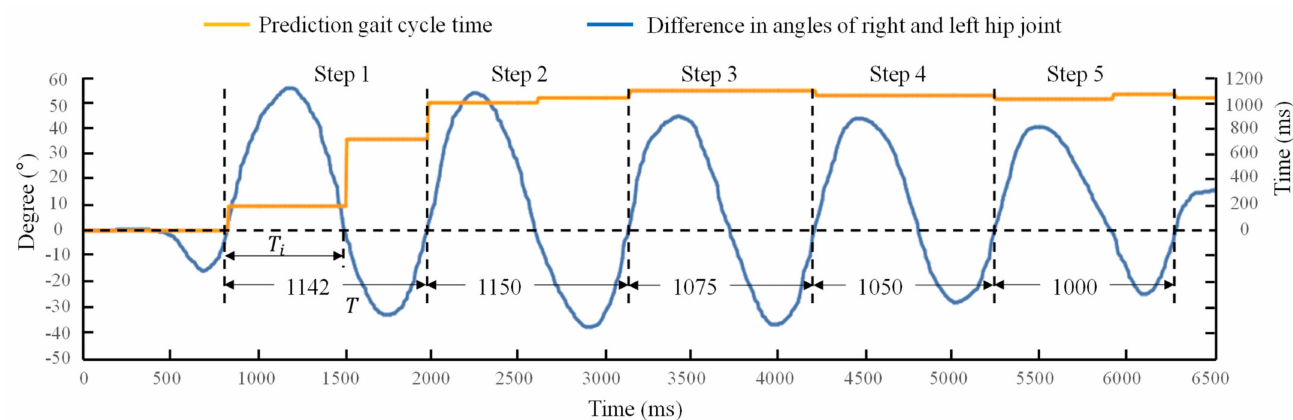
Figure 7. The difference in angles of right and left hip joint and prediction gait cycle time. T i is the time between two feature angles, T is a complete gait cycle time.